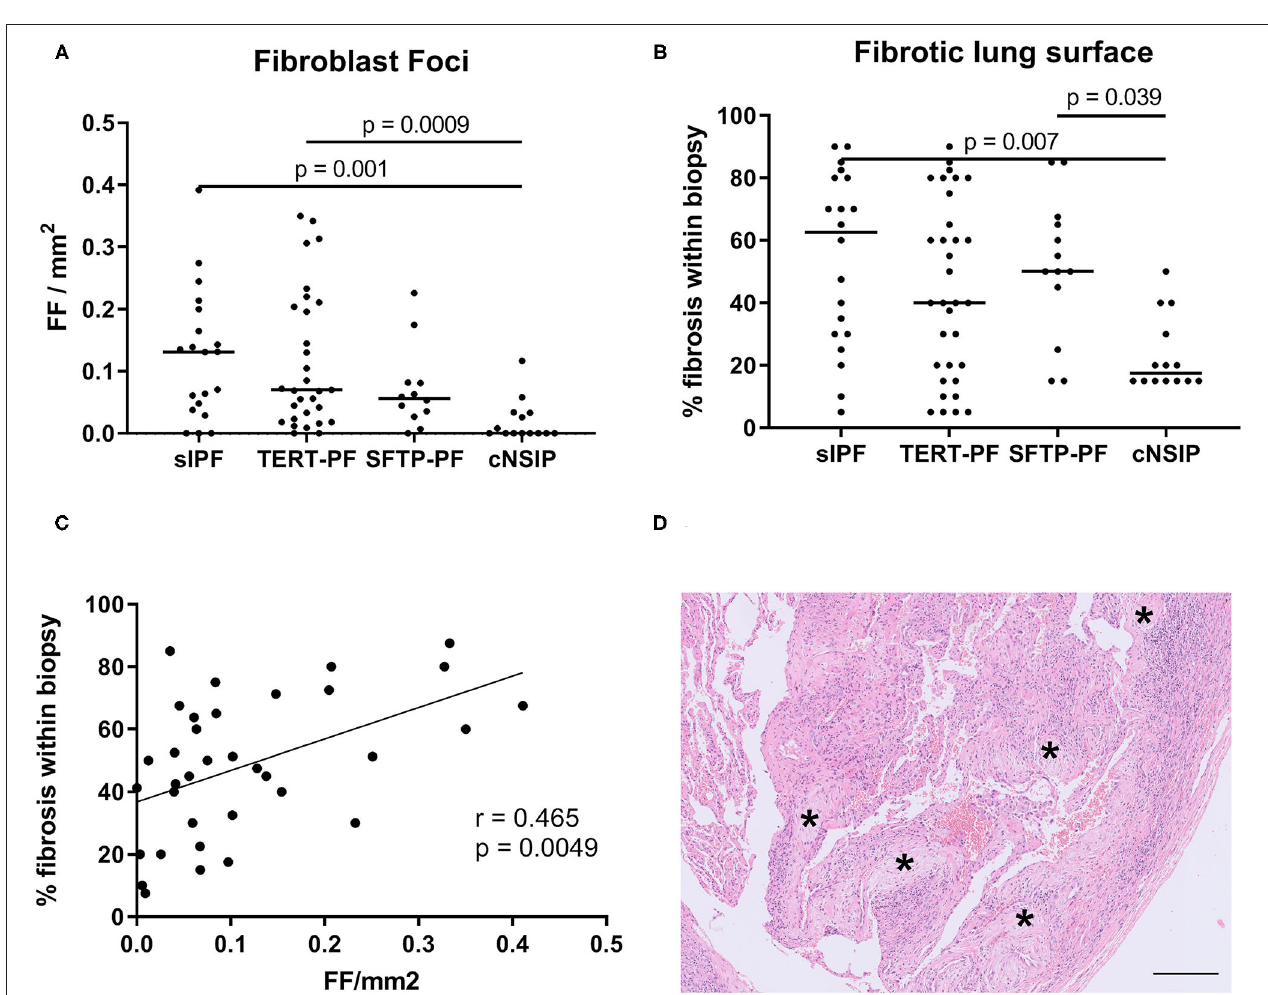
FIGURE 2 | ( p = 0.04, Kruskal–Wallis test). The inflammatory cell infiltrate in non-fibrotic vs. fibrotic areas showed that lymphocyte aggregates and the diffuse lymphocyte cell infiltrate were associated with fibrotic areas in TERT-PF, SFTP-PF, and sIPF lungs (Mann–Whitney tests; p < 0.0001). Also the extent of lymphocyte aggregates ( p = 0.0005) and the diffuse lymphocyte cell infiltrate ( p < 0.0001) in cNSIP lungs was significantly higher than in non-fibrotic areas in PF lungs. No significant differences were found between fibrotic areas in PF and cNSIP lungs. Horizontal bars represent medians. (E–H) Examples of lymphocyte aggregates and diffuse lymphocyte cell infiltrate in Hematoxylin and Eosin (H&E)-stained diagnostic biopsies; (E) fibrotic area in a TERT-PF case with 3 lymphocyte aggregates (arrows) and (F) grade 2 diffuse lymphocyte cell infiltrate; (G) non-fibrotic area in an sIPF case with no lymphocyte aggregates and grade 1 diffuse lymphocyte cell infiltrate; ( H ) cNSIP case with grade 4 diffuse lymphocyte cell infiltrate. Horizontal bars represent a size of 200 µ m. TERT-PF, Patients with lung fibrosis and a TERT mutation; SFTP-PF, Patients with lung fibrosis and a surfactant mutation; sIPF, Sporadic idiopathic pulmonary fibrosis; cNSIP, Cellular non-specific interstitial pneumonia; LA, Lymphocyte aggregates.